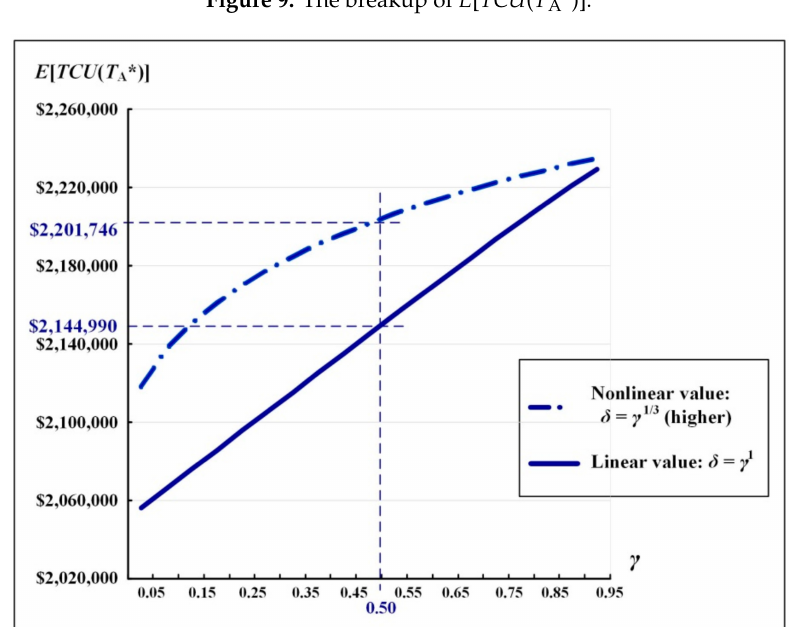
Figure 10. The impact of common part’s linear and nonlinear values on E [ TCU ( T A